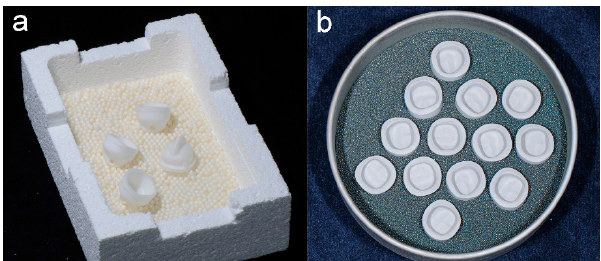
Figure 2. Comparison of the sintering procedures: Sinter support structure with Y-TZP secondary crowns ( a ); and CoCr primary crowns ( b ).